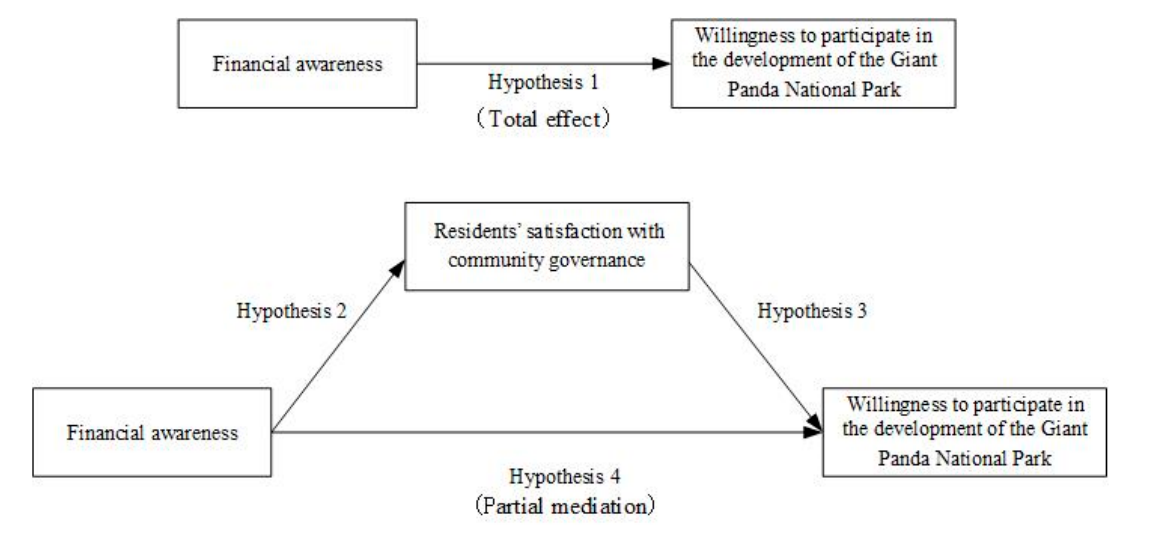
Figure 1. The analysis framework of the influence mechanism of financial awareness and community governance on residents’ willingness to participate in the development of Giant Panda National Park.